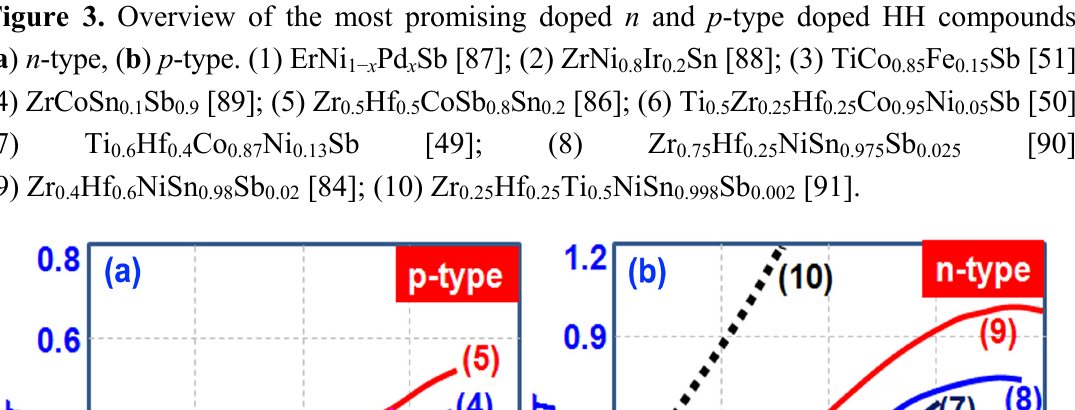
Figure 3. Overview of the most promising doped n and p -type doped HH compounds: ( a ) n -type, ( b ) p -type. (1) ErNi